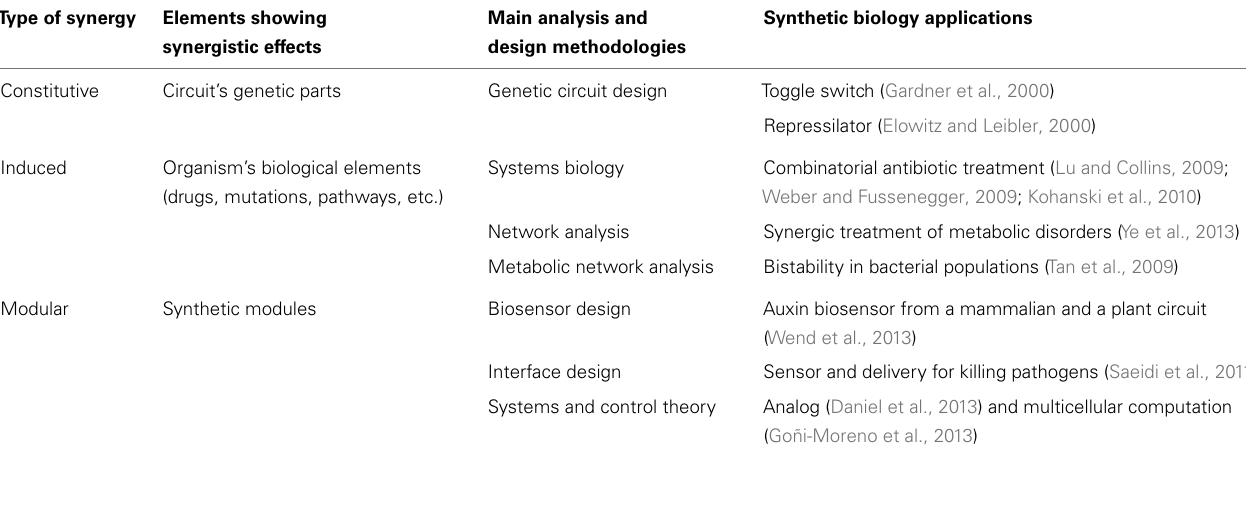
Table 2 | Examples of synthetic biology synergistic